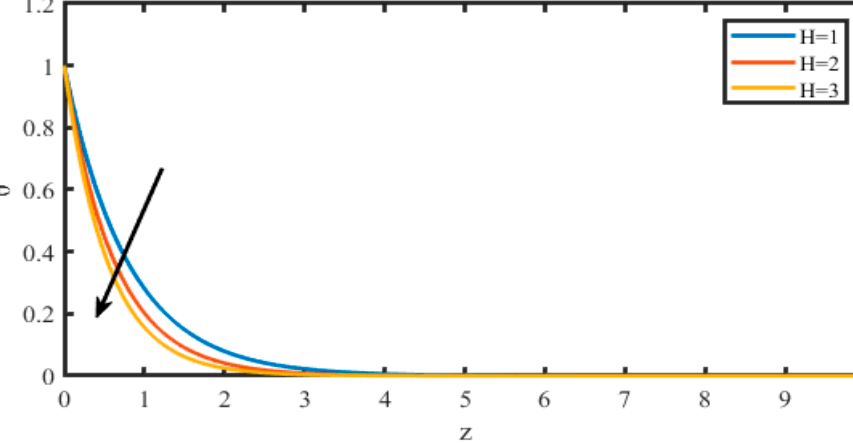
Figure 13. The influence of the Chemical reaction parameter Kc on the Concentration profiles. Figure 14 demonstrates how the species concentration ϕ rises along with the number of Sorets. A rise in the Soret effect, by definition, indicates an increase in molar mass dif- fusivity. An increase in the increase in concentration is due to molecule mass diffusivity. This shows that the species concentration in the fluid tends to rise as the Soret number rises. Figure 15 illustrates the behavior of the Schmidt number (Sc) on the concentration curves. The momentum to mass diffusivity ratio is represented by the Schmidt number Sc. It determines the relative effectiveness of momentum and mass transmission by em- ploying diffusion in the hydrodynamic (velocity & concentration) boundary layer. As well as the Schmidt number decreases, the fluid’s mass diffusivity.